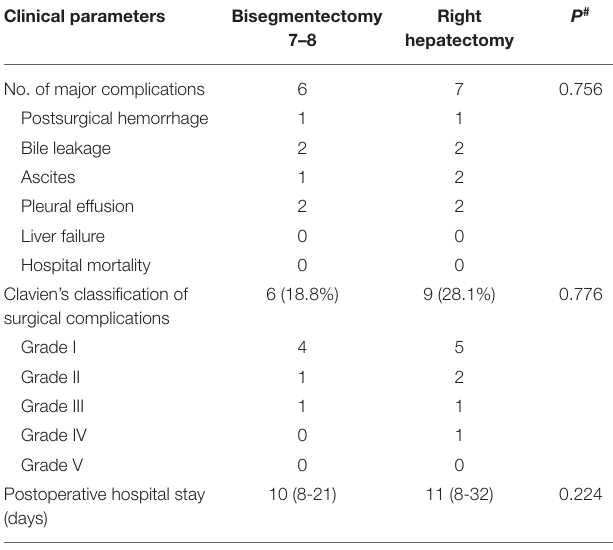
TABLE 3 | Postoperative complications and hospital